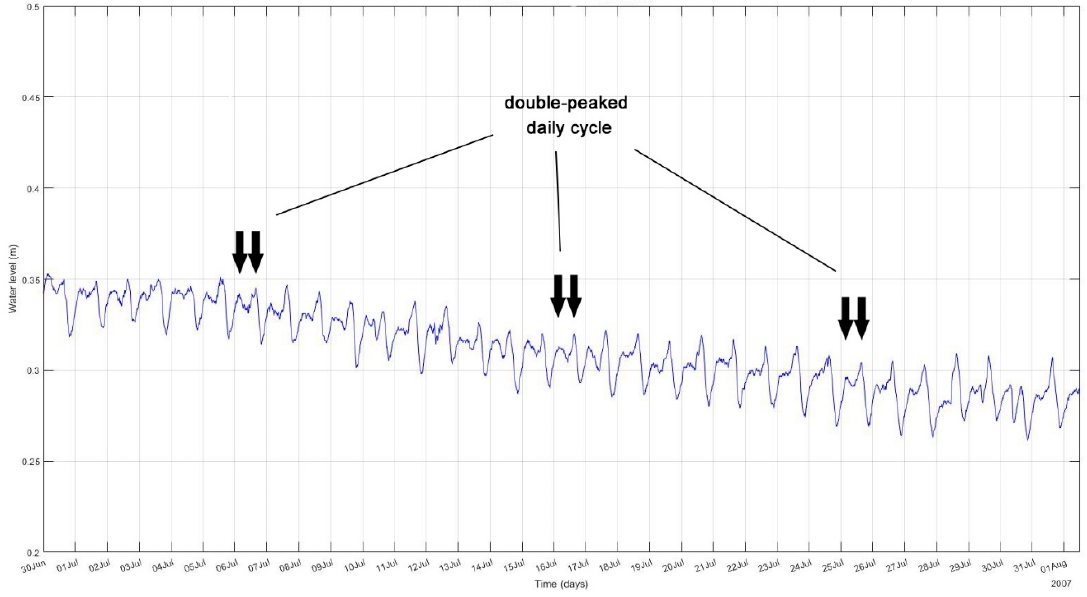
Figure 2. Diurnal variation of Koiliaris River stage highlighting the double peaks in the daily cycle.